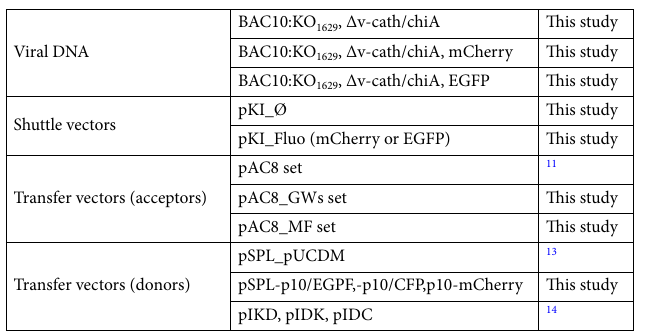
Table 1. Components of the HR-Bac